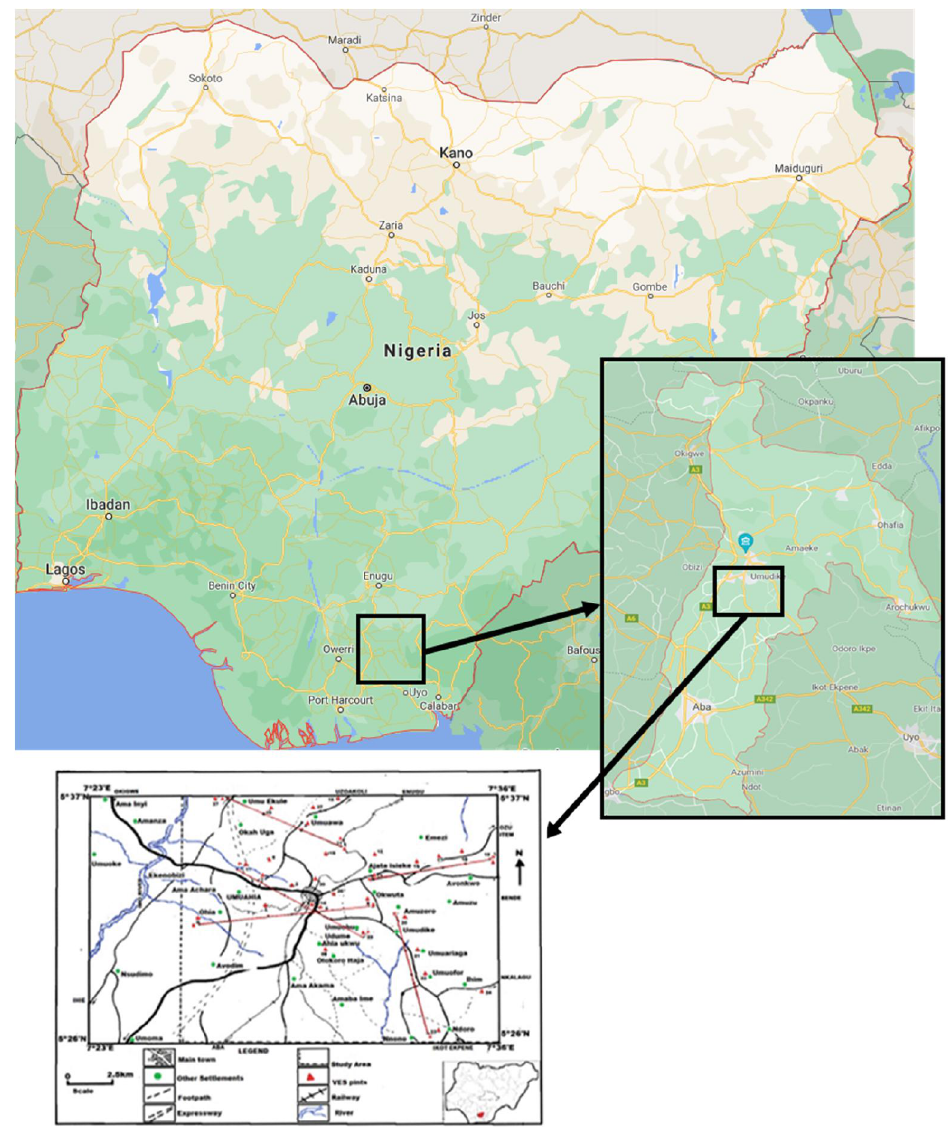
Figure 1. Map of the study